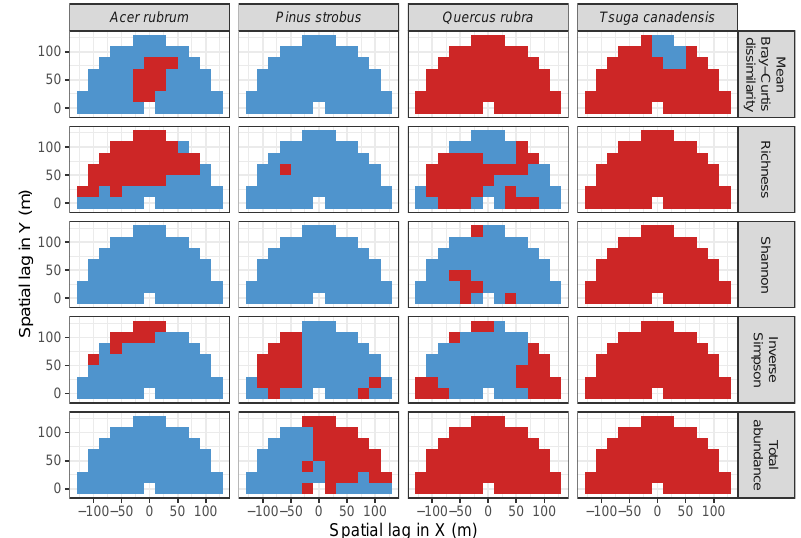
Figure 9. Statistical significance (red: P 0.05; blue: P > 0.05) of the codispersion coefficients calculated between measures of diversity and total basal area of the four dominant species in 20 subplots in the 35-ha Harvard Forest plot (Figure 8). Statistical significance was determined by comparing observed codispersion at each spatial lag with a distribution of 199 spatial randomizations of a toroidal-shift null model.